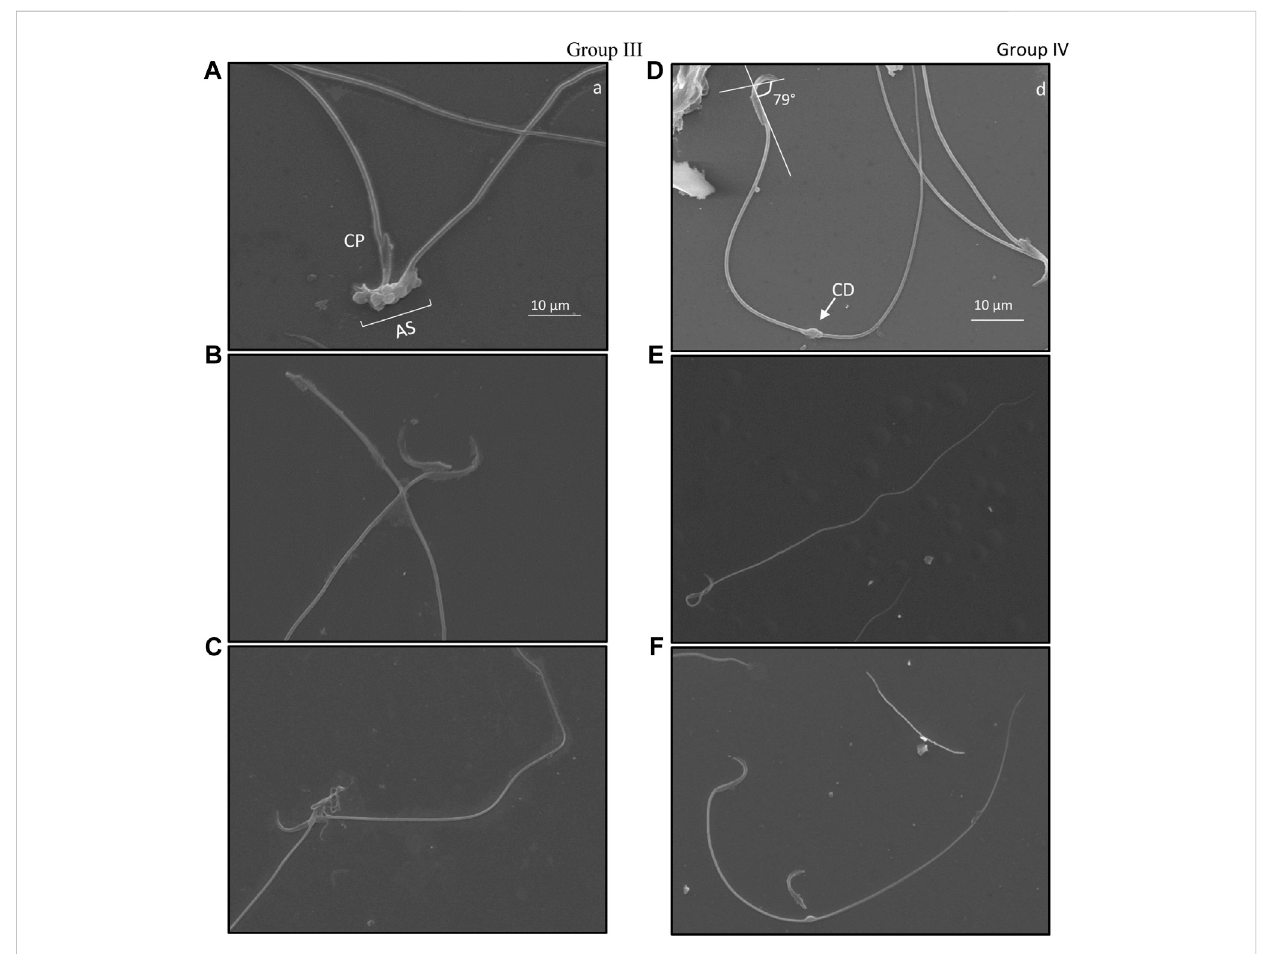
FIGURE 5 Ultrastructure of cauda epididymal sperm indicating types of damage exclusively present in mice exposed to 6 Gy gamma irradiation. Damage was primarily found in the acrosomal system (AS) where angular deviation of the perforatorium (P) was higher than that of the outer periphery but lower than thatoftheventralperiphery.Ventralspur(VS)ledtotheangularbendintheapical(A)acrosomalsystem.Theconnectingpiece(CP)wasdislocateddueto headandtailseparation.Cytoplasmicdroplets(CD)werecommonintheplasmamembrane;thesewerefoundinbothheadandtailsections.Group III, (A – C) ; Group IV, (D – F)